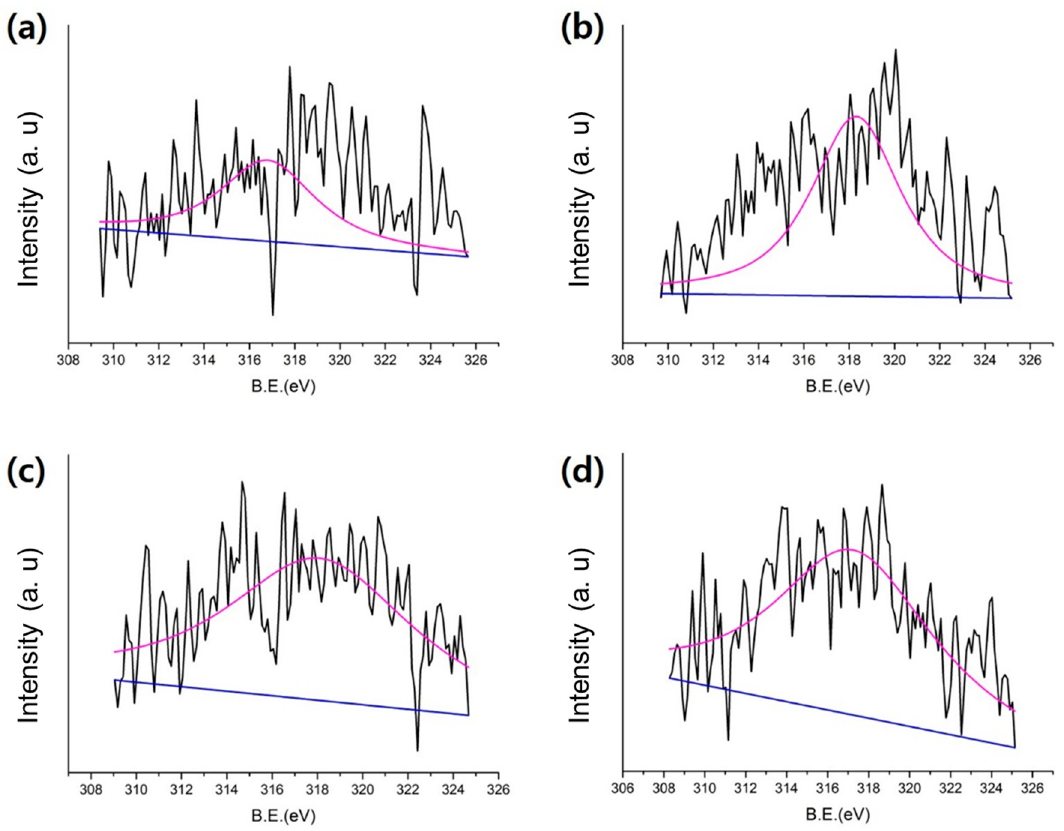
Figure 9. XPS Ar sputter profile Pt 4d spectra of ( a ) SR550 6s, ( b ) SR550 18s, ( c ) Cal600 6s, and ( d ) Cal600 18s (B.E. = binding energy).